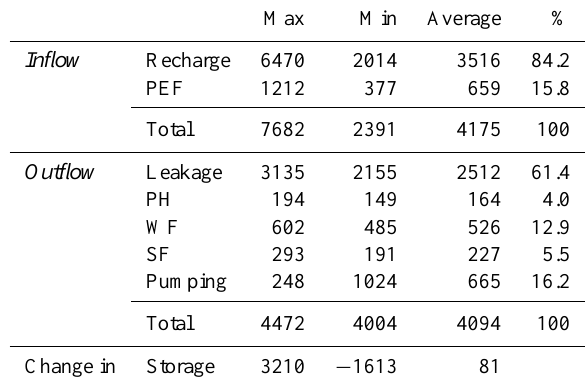
Table 3. Model mass balance (volumetric rates expressed in hm 3 yr − 1 , percentages referred to average rates) – PEF: prescribed eastern flow; PH: prescribed head; WF: western flow; SF: south- ern flow. Maximum values correspond to the forth simulated year; minimum values correspond to the thirtieth simulated